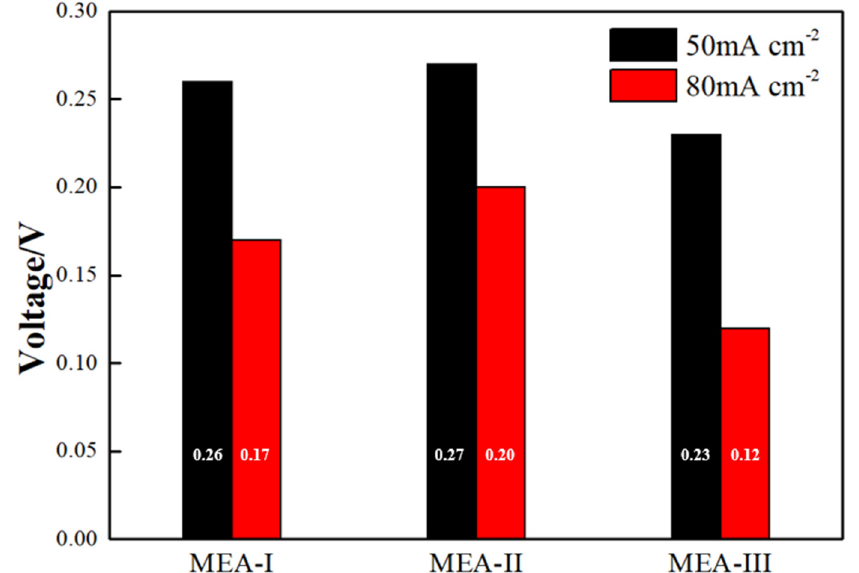
Figure 4. Voltage values corresponding to several current density points in the above polarization curves at 40 °C.